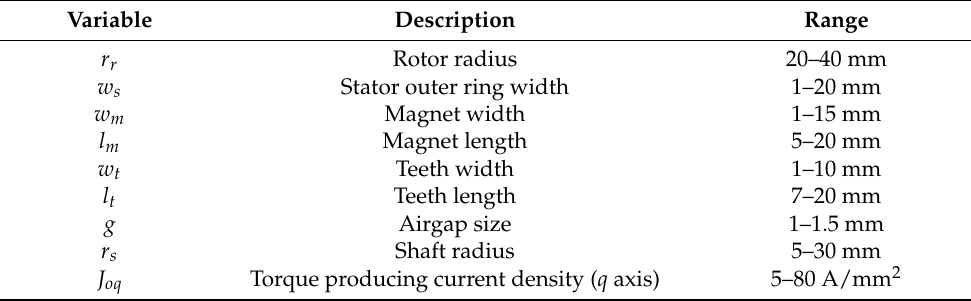
7 of 22 Figure 8. Interior permanent magnet synchronous machine model geometry for optimization, de-